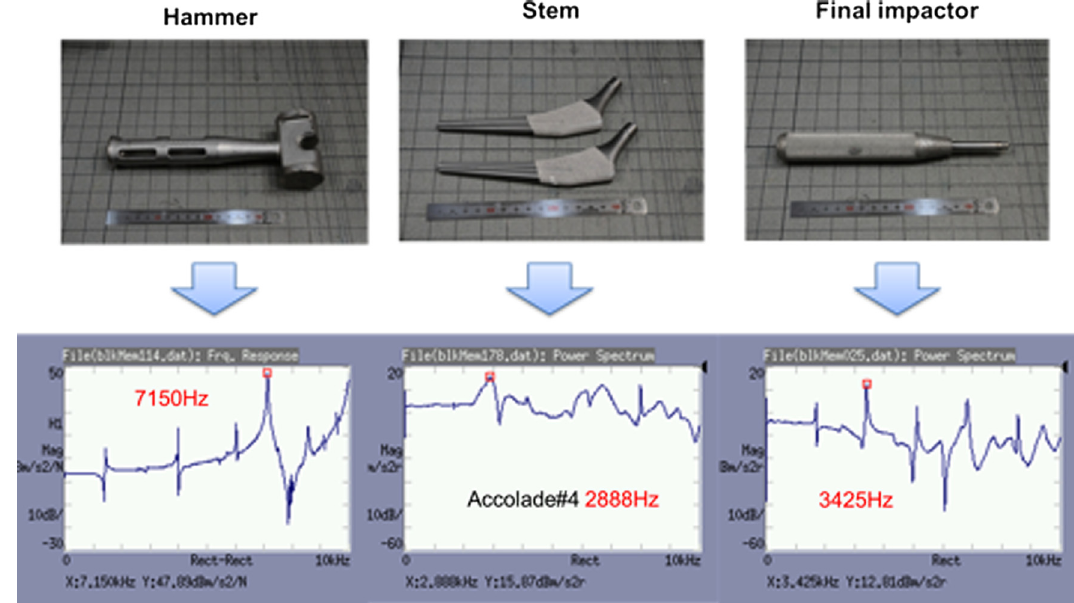
Figure 3. Identification of the natural oscillation frequency of each